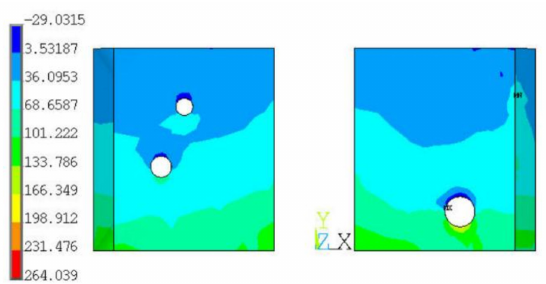
Figure 7. The e ff ect of void size and location on the first principal stress distribution of the solder